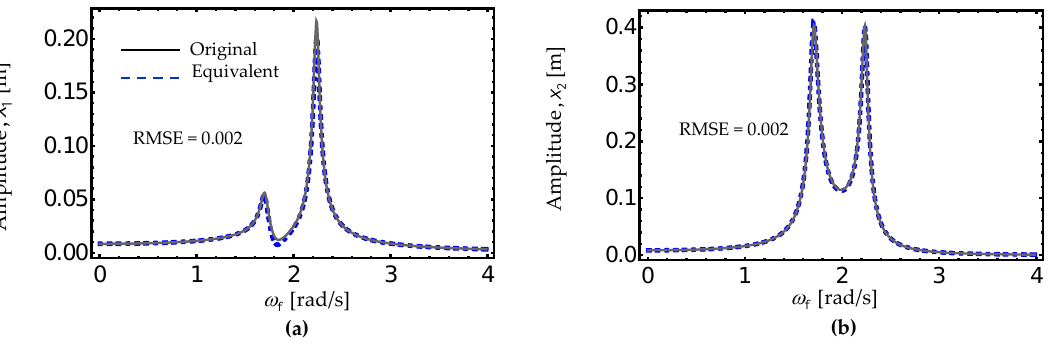
Figure 8. Frequency-amplitude response curves: ( a ) x 1 vs ω f , ( b ) x 2 vs ω f . These were computed from the numerical integration solutions of Equations (29) and (43). The parameter values used to obtain these plots were m 1 = 10 kg, m 2 = 0.6 kg, c 1 = 0.1 Ns/m, c 2 = 0.08 Ns/m, k 1 = 44 N/m, k 2 = 8 N/m 3 , k 3 = 2 N/m, k 4 = − 0.15 N/m 3 , f 0 = 0.37 N. Here, the black, solid lines describe the numerical integration solution of Equation (43), while the blue, dashed lines represent the numerical solutions obtained from the derived equivalent nonlinear equations of motion (29).